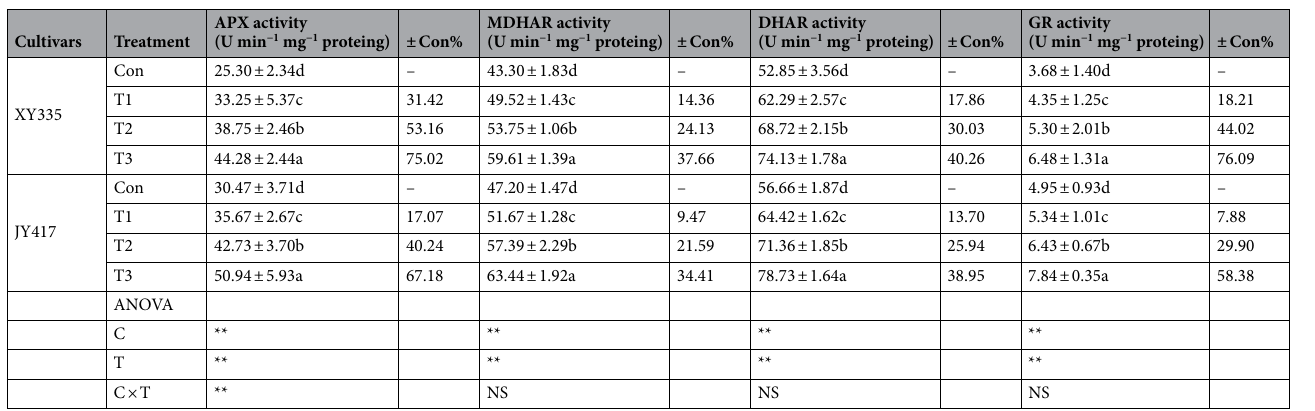
Table 6. Influence of T. asperellum on the antioxidant enzyme activities in the roots of maize seedlings in saline–alkaline soil (± SD). Con, T1, T2, and T3 indicate 0, 1 × 10 3 , 1 × 10 6 , 1 × 10 9 spores L −1 suspension, respectively. Antioxidant enzyme activities were measured on the 27th day after T. asperellum application. C and T indicated cultivars and treatments, respectively. Different letters within a column represented significant differences at 5% probability level, and the numerical value was the mean value of five repeats. Differences between treatments were calculated for each particular cultivar. NS, not significant. * and **, significant at the 0.05 and 0.01 probability level,